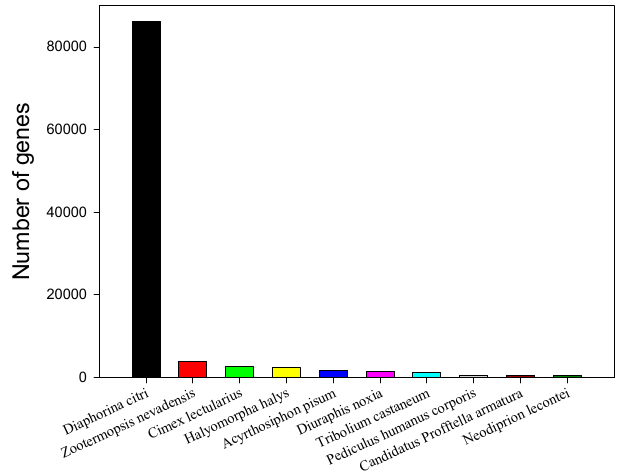
Figure 2. Top 10 species distribution of the BLASTX top hits results. Species distribution of the unigene BLASTX top hits results against the National Center for Biotechnology Information (NCBI) non-redundant protein database using a cuto ff E-value of 10 − 5 and the proportions of each species are shown. Each bar represents a di ff erent